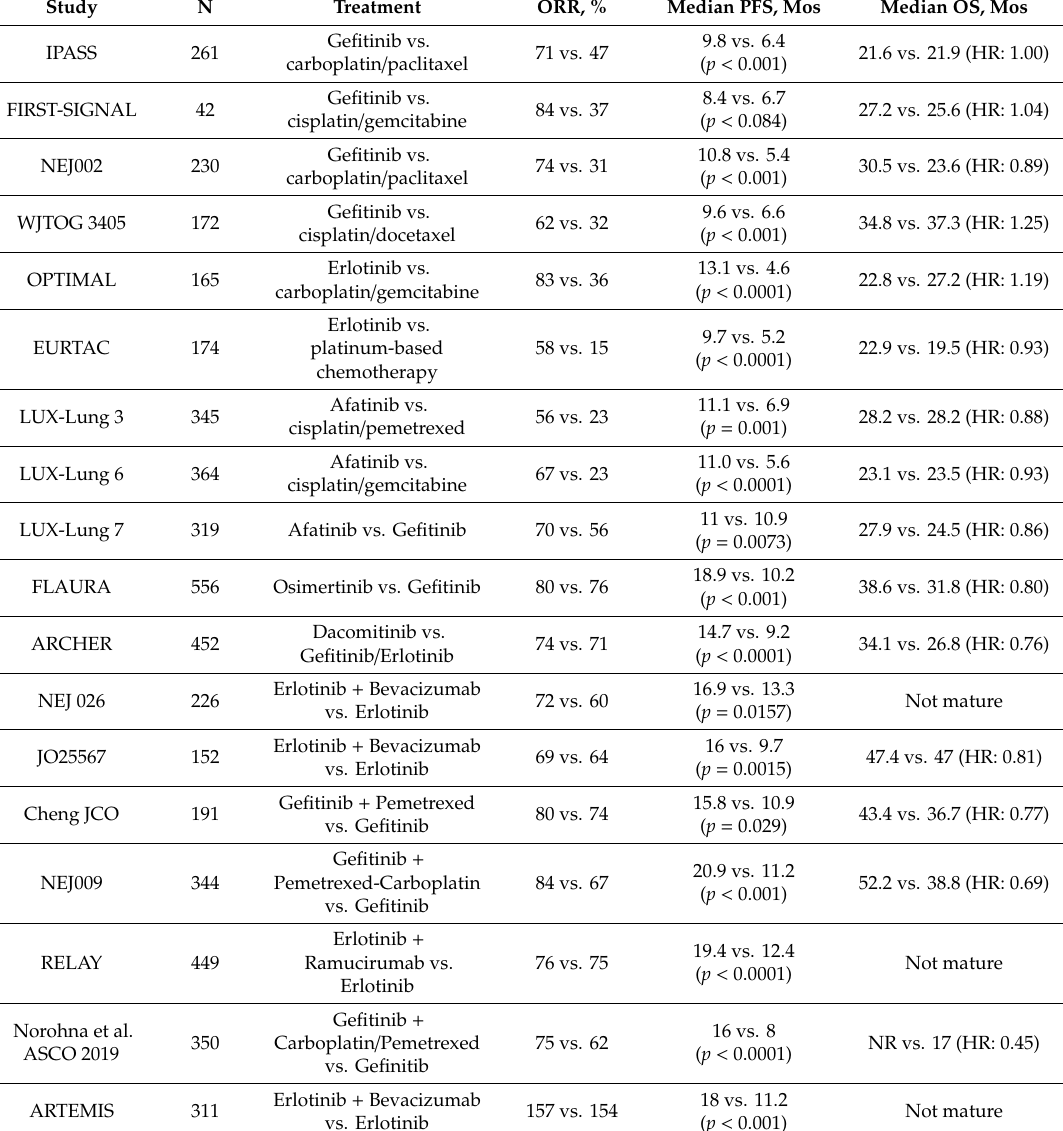
Table 4. Phase 3 comparative studies in the targeted therapy of EGFR mutant non-small-cell lung cancer